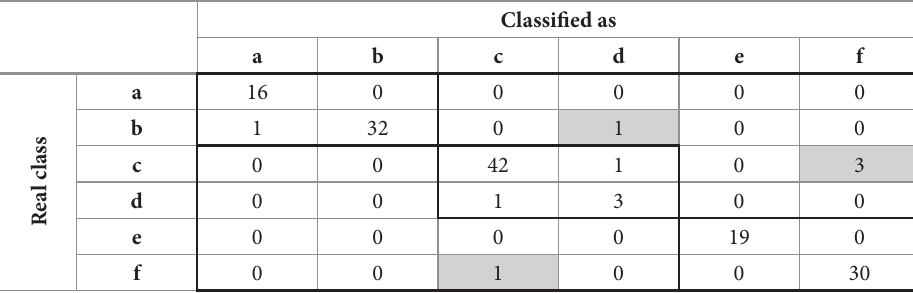
Table 4. Confusion table for decomposed classes. Different combination for class